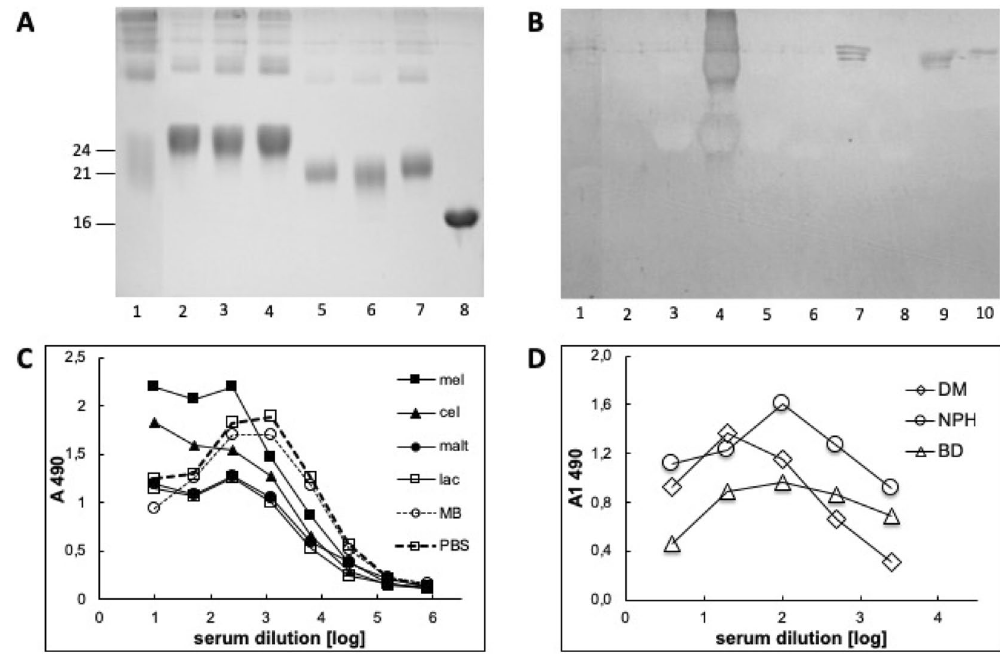
Figure 1. Autoantibodies present in human serum bind different model AGEs. ( A ) 12.5% SDS-PAGE separation of MB (lane 8) and its glycation products obtained in HTG reaction with: lac (lane 1), mal (lane 2), cel (lane 3), mel (lane 4), glc (lane 5), man (lane 6), gal (lane 7). Molecular mass is indicated with lines on the left side of the picture. ( B ) WB of serum from diabetic patient with control unmodified protein MB (lane 8), BSA (lane 9), and model AGEs: MB-lac (lane 1), MB-mal (lane 2), MB-cel (lane 3), MB-mel (lane 4), MB-glc (lane 5), MB-man (lane 6), MB-gal (lane 7), BSA-lac (lane 10) formed in HTG or HPG conditions (lane 1–7 and 10, respectively). ( C ) ELISA of serum from diabetic patients on a plate coated with unmodified MB (open circle) or MB glycated by different carbohydrates (filled marks); the control of secondary Ab were evaluated on wells with BSA as a blocking agent (open square); values presented are of serum from a representative patient; ( D ) ELISA with representative sera from diabetic (DM), diabetic nephropathy (NPH) and Buerger’s disease (BD) patients on plate coated with MB-mel; the results (A 1 490) were normalized by subtraction of the absorption of secondary Ab (PBS in place of